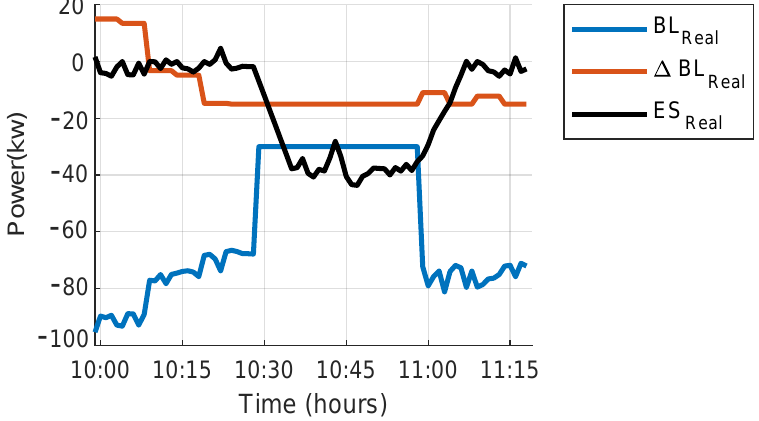
Figure 14. Scenario 2—battery and building load